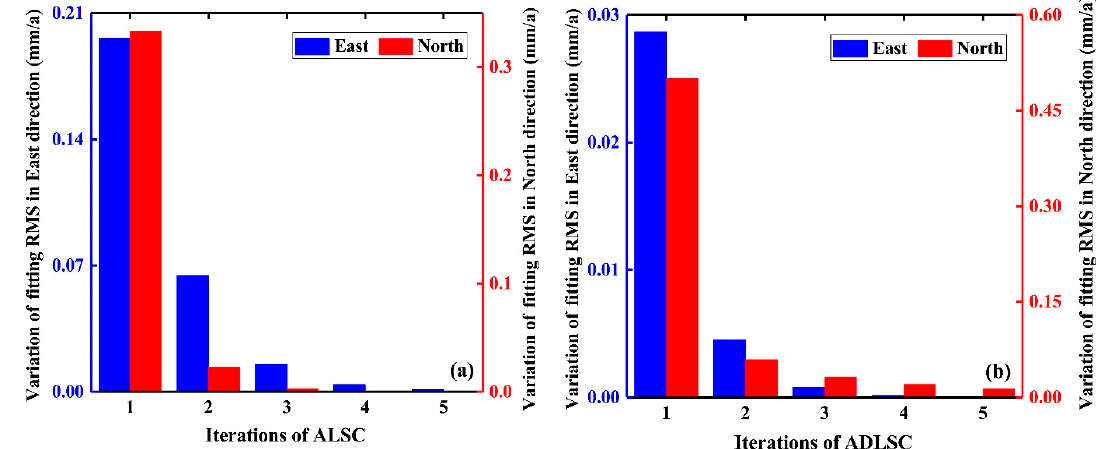
Figure 9. Comparison of the iteration times and fitting RMS in the iterative process of the VCEM calculation: ( a ) east direction; ( b ) north direction.